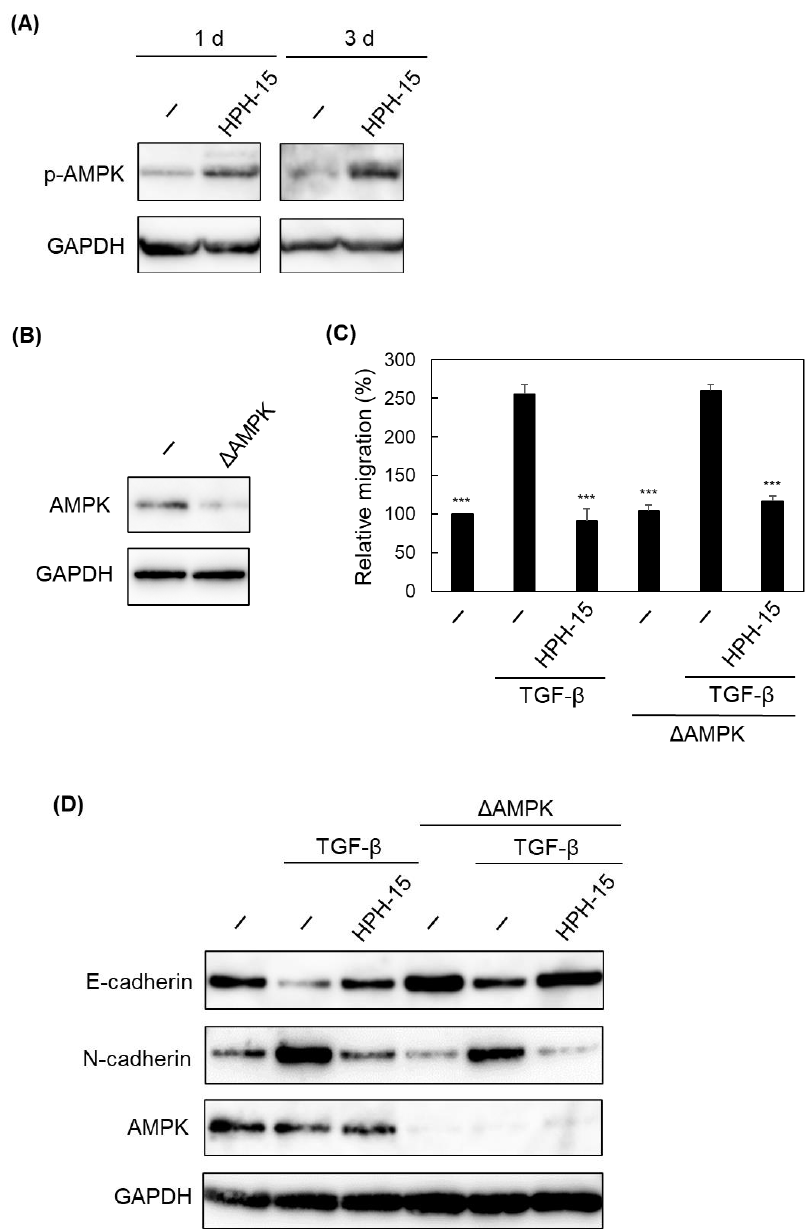
Figure 6. Effects of HPH-15 on AMPK activation. ( A ) Protein levels of phosphorylated AMPK in TGF- β -stimulated A549 cells treated with HPH-15. After incubating the cells for 1 d or 3 d in the presence of HPH-15 (10 µ M) and TGF- β (10 ng/mL), the cells were lysed. The lysate was analyzed by immunoblotting. ( B ) Protein levels of AMPK in AMPK-knockdown A549 cells. After transfection of siRNA into A549 cells and incubation for 1 d, the cells were lysed. The lysate was analyzed by immunoblotting. ( C ) Migration of TGF- β -stimulated AMPK-knockdown A549 cells treated with HPH-15. In vitro scratch assays of the cells, incubated with various amounts of HPH-15 and TGF- β (10 ng/mL) for 1 d, were performed. Relative values are shown. ( D ) Protein levels of E-cadherin and N-cadherin in TGF- β -stimulated AMPK-knockdown A549 cells treated with HPH-15. After incubating the cells for 3 d in the presence of HPH-15 (10 µ M) and TGF- β (10 ng/mL), the cells were lysed. The lysate was analyzed by immunoblotting. *** p < 0.001 compared with samples treated with TGF- β and without